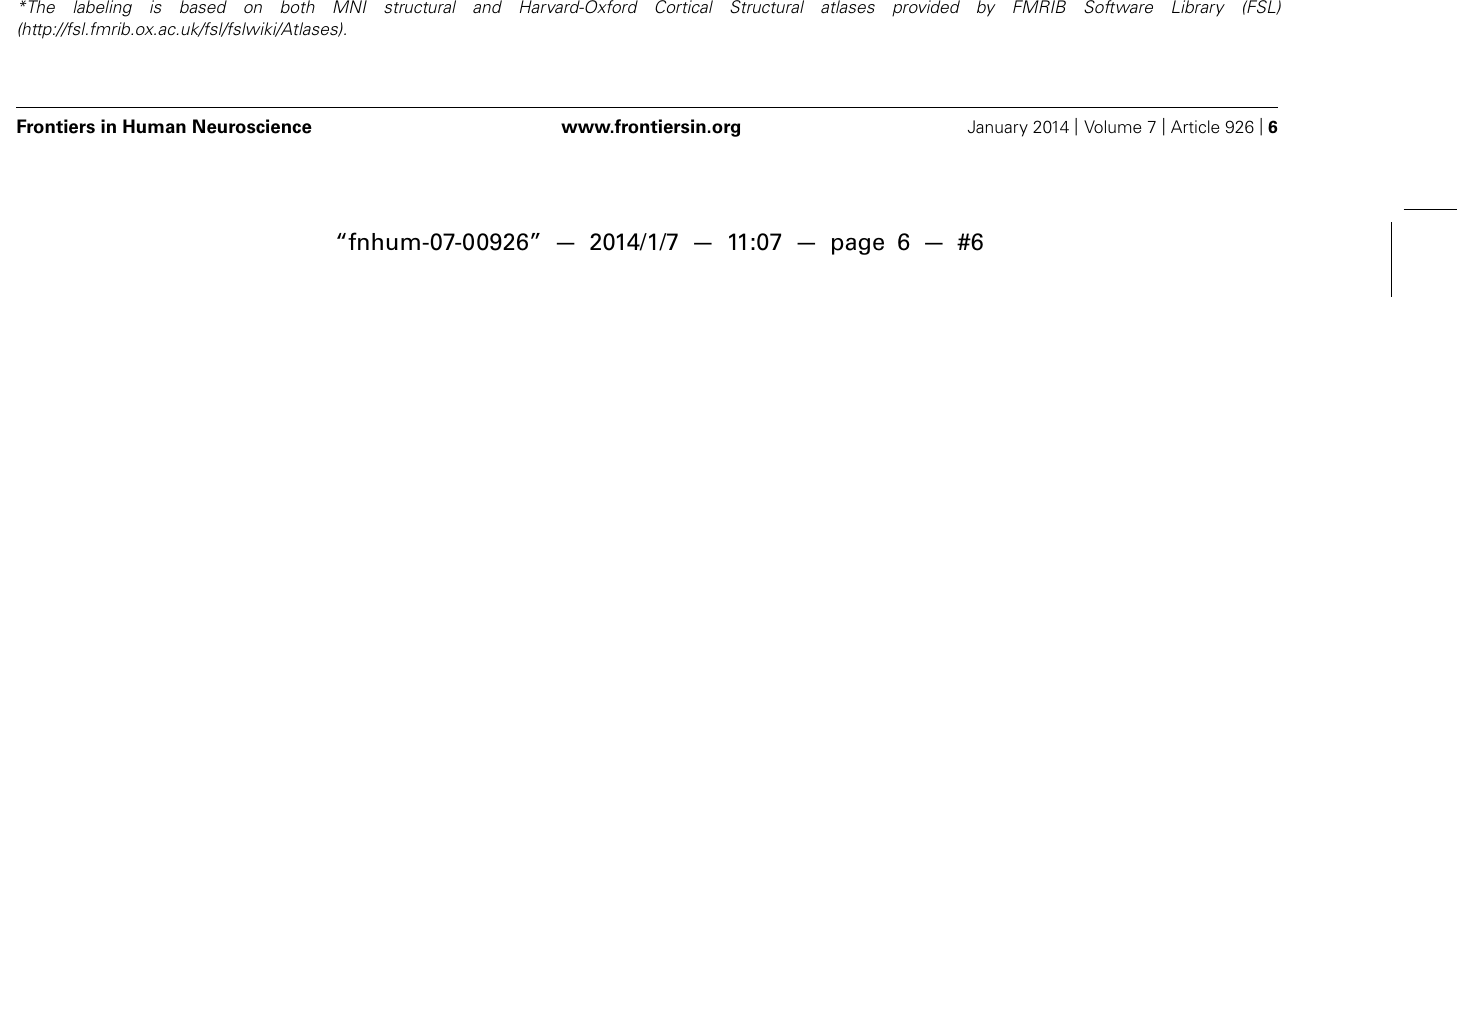
Table 3 | Significant association between playing a musical instrument and gray matter volume. Clusters overlap with* P corrected Temporo-occipital fusiform gyrus, Inferior temporal gyrus 0.008 Insula, caudate, and